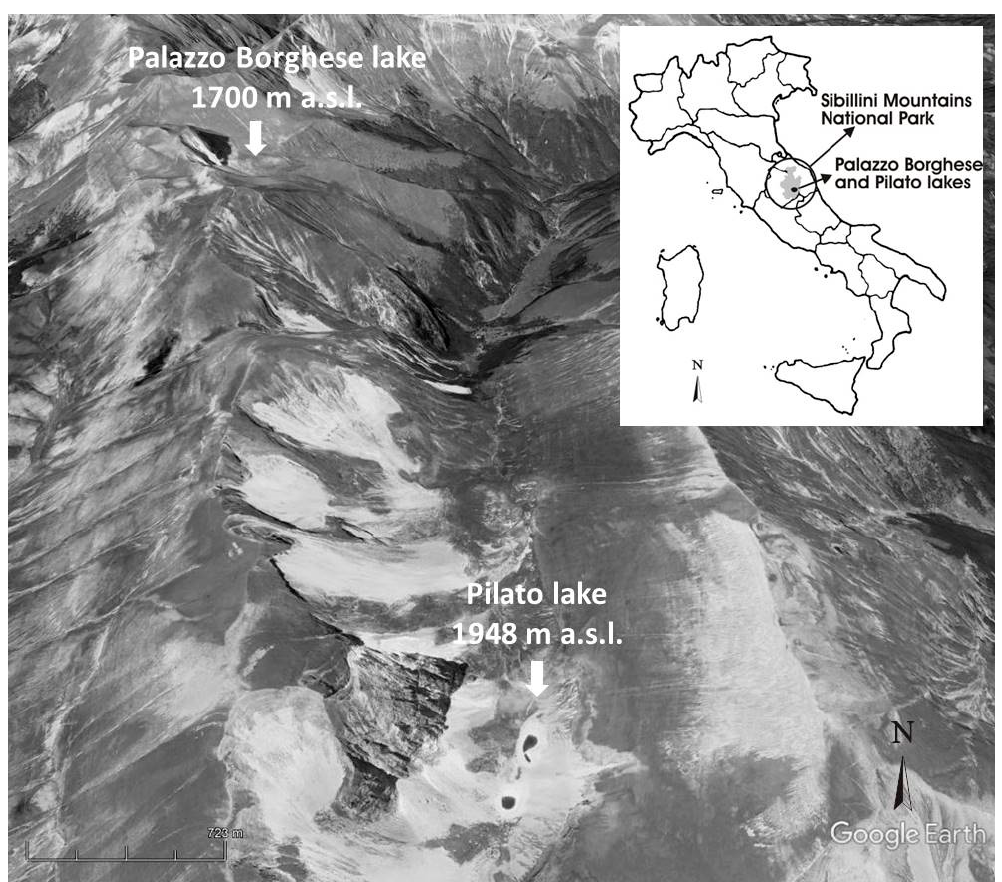
Figure 1. Study area location and elevation of the Pilato and Palazzo Borghese lakes (photo taken on 29 June 2020). © 2021 Google.